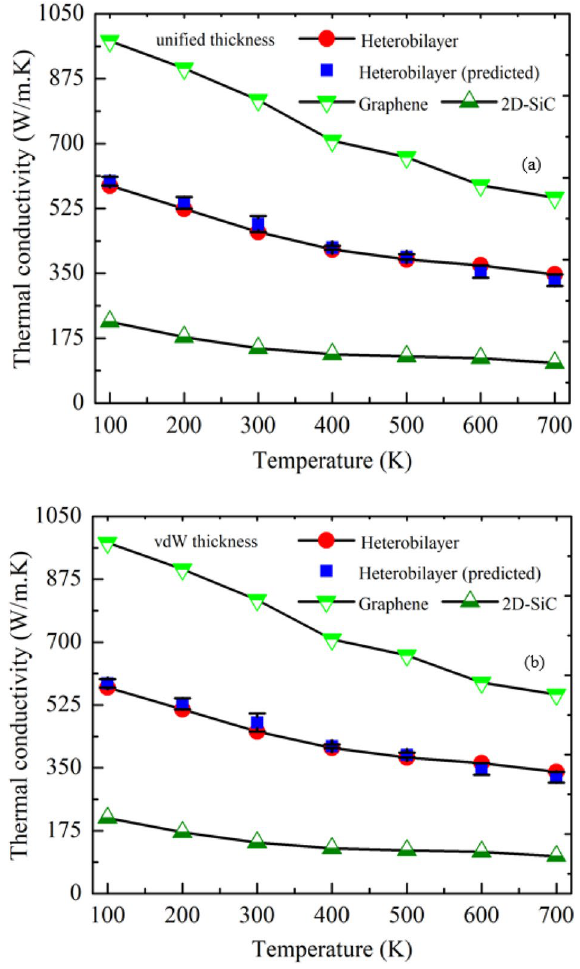
Figure 2. Temperature dependence of thermal conductivity of graphene, 2D-SiC and the hetero-bilayer from 100 to 700 K at ( a ) unified thickness and ( b ) vdW thickness (Coupling strength χ = 1). Each data point is averaged from three independent simulations with different initial